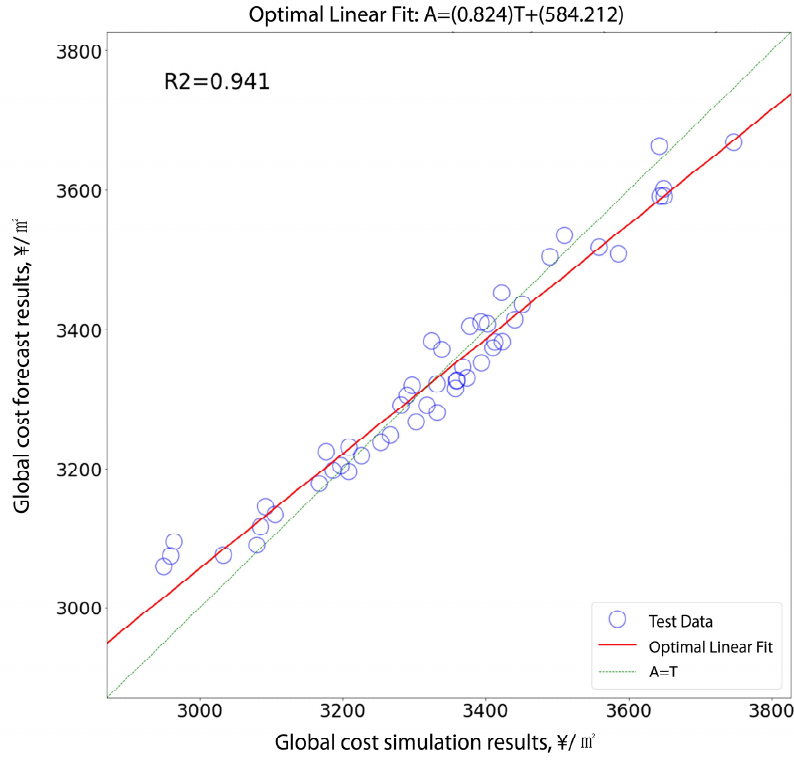
Figure 19. Prediction model for building global